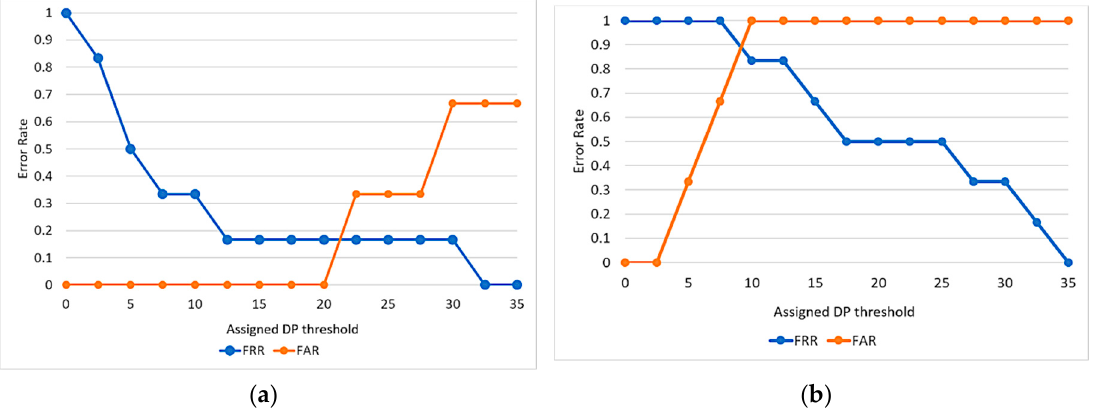
Figure 17. Examples of FRR–FAR curves in the cases where: ( a ) reference data is P1; ( b ) reference data is P6. In each graph, the horizontal axis indicates assigned DP thresholds. The vertical axis indicates error rate.